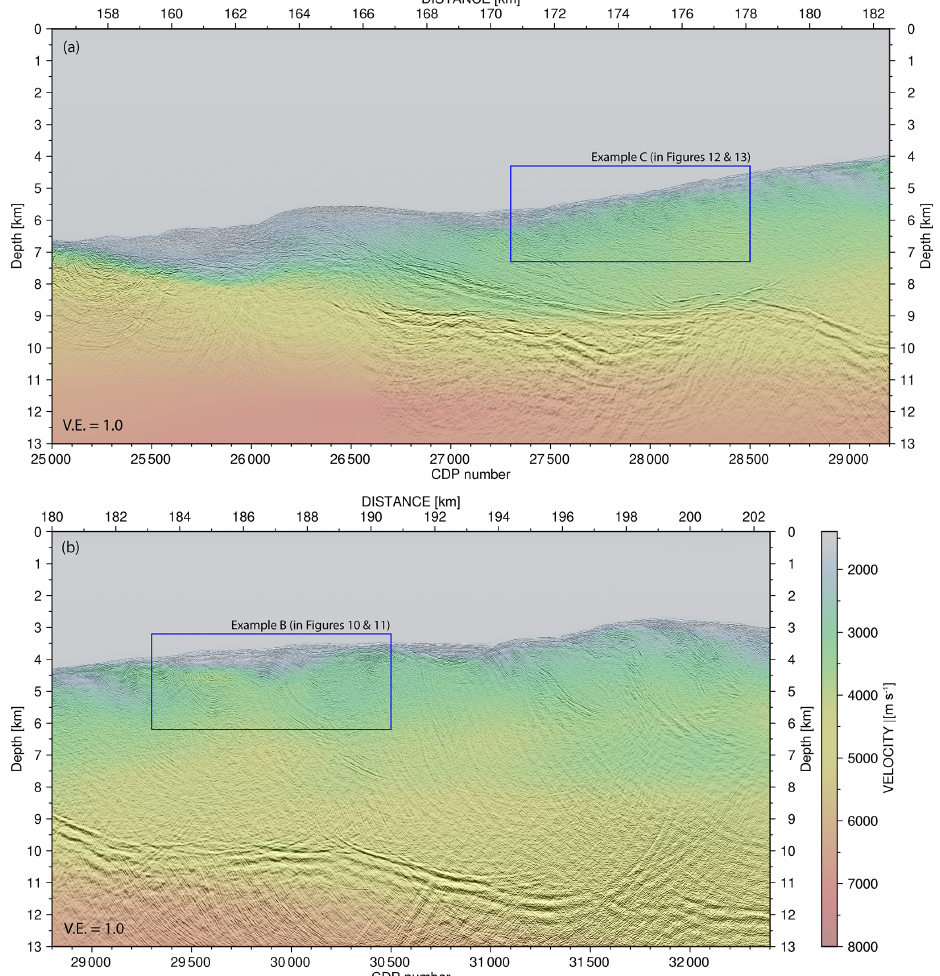
Figure 9. Depth migration stack section of five iterations depth tomography with final velocity model overlain. The location of the profile is illustrated in Fig. 5 as a yellow line. Rectangular boxes are discussed in the section on field data examples from the accretionary wedge. (a) Data example C. (b) Data example